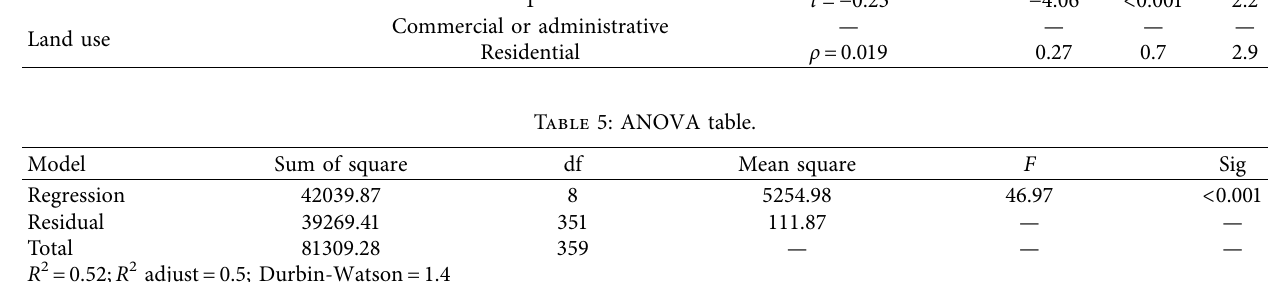
Table 6: The correlation matrix.